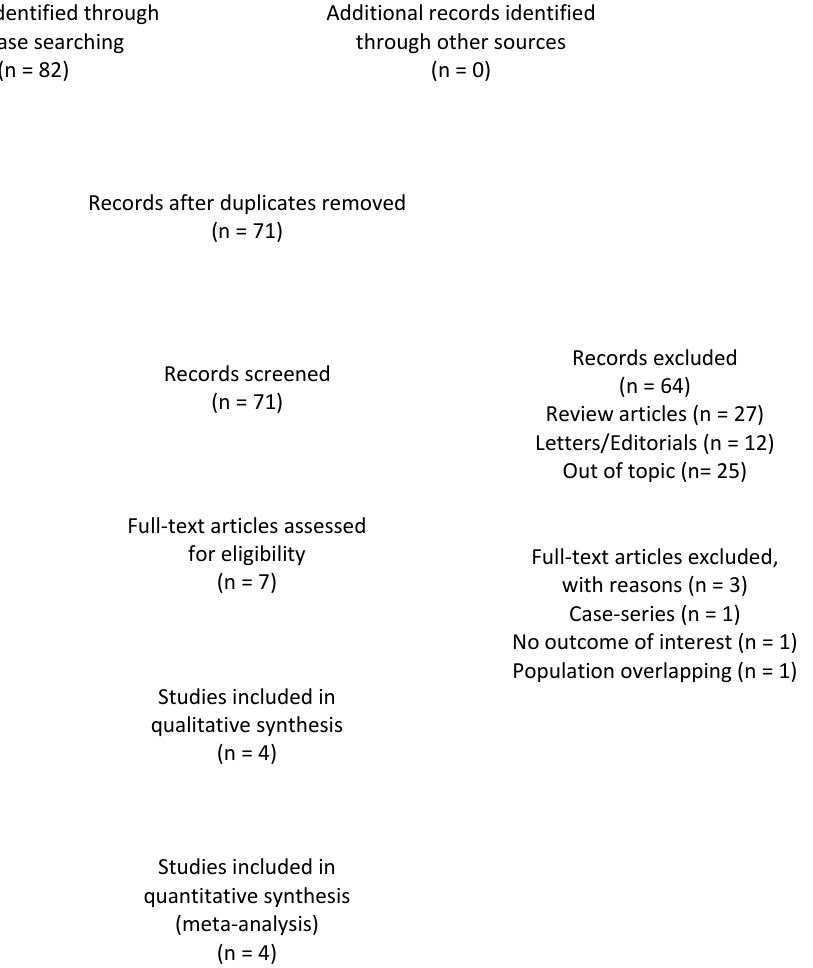
Figure 1. Flowchart of studies included in systematic review and meta-analysis.